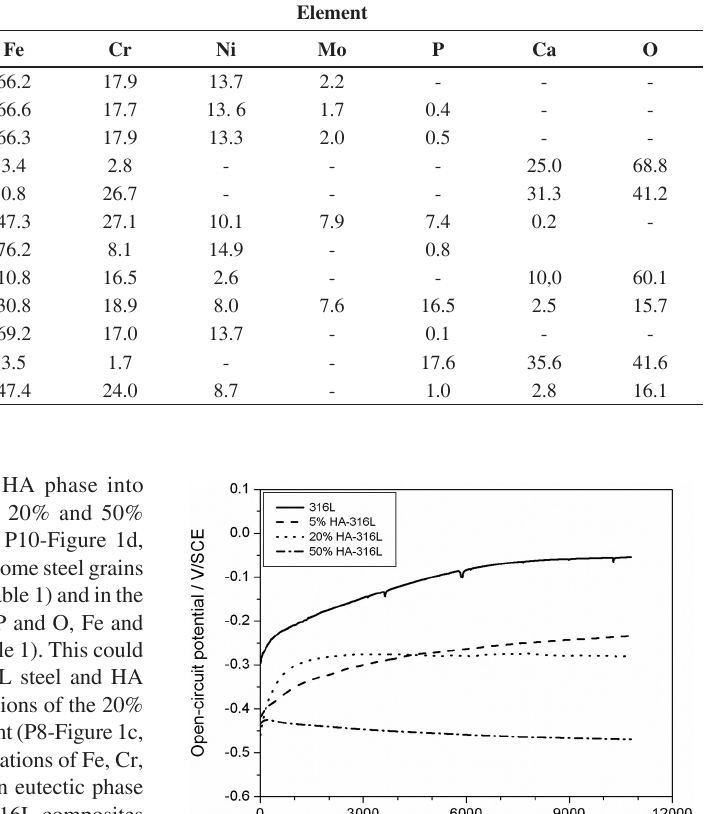
Table 1. Microanalysis by EDS of sintered 316L and HA‑316L composites (wt. (%)). Material / Region